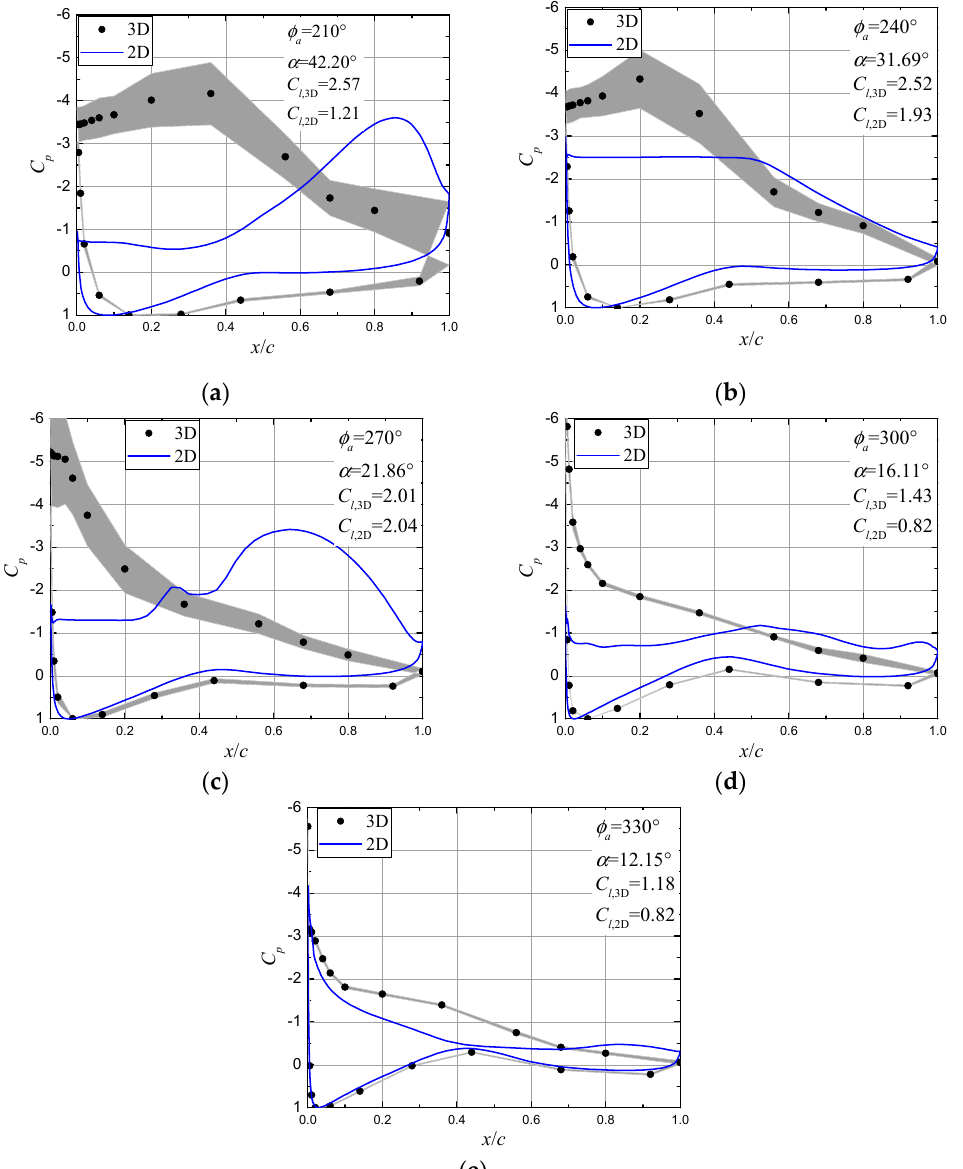
Figure 14. Azimuthal variation of the pressure distributions on the downwind side of rotor plane. r / R = 30%, V w = 15 m/s, and ϕ y = 30°. 3D data are mean ± SD. ( a ) ϕ a = 210°; ( b ) ϕ a = 240°; ( c ) ϕ a = 270° ( d ) ϕ a = 300°; ( e ) ϕ a = 330°.